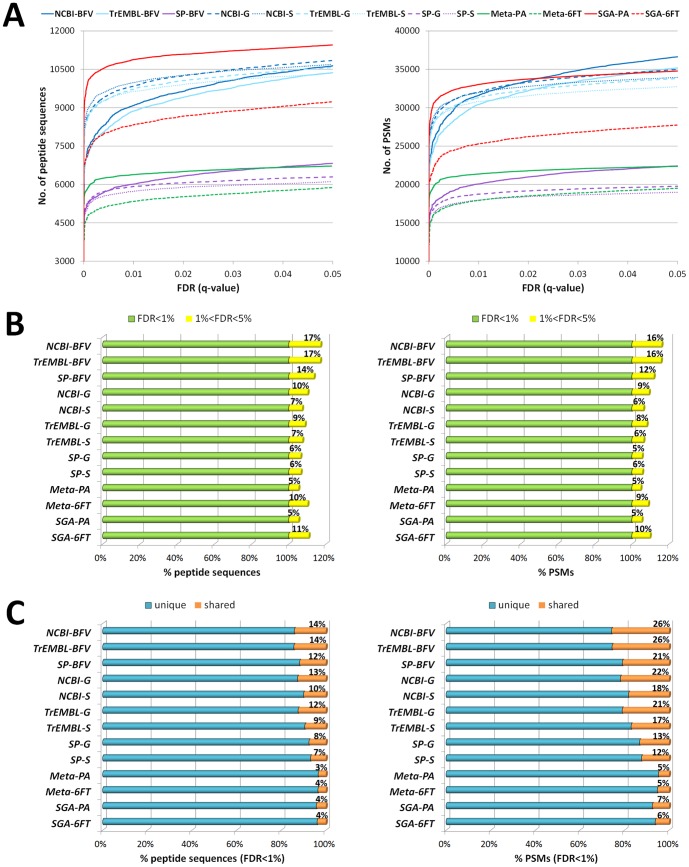
Evaluation of FDR behavior and peptide degeneracy using different databases.A) Diagram plotting the number of peptides (left) and PSMs (right) identified with each database as a function of FDR thresholds based on the Percolator q-values. B) Bar graph showing the percentage increment in peptide (left) and PSM (right) identifications achieved with each database when increasing the FDR threshold from 1 to 5%. C) Bar graph illustrating the percentage of shared peptides (left) and PSMs (right) identified with each database at FDR<1%.